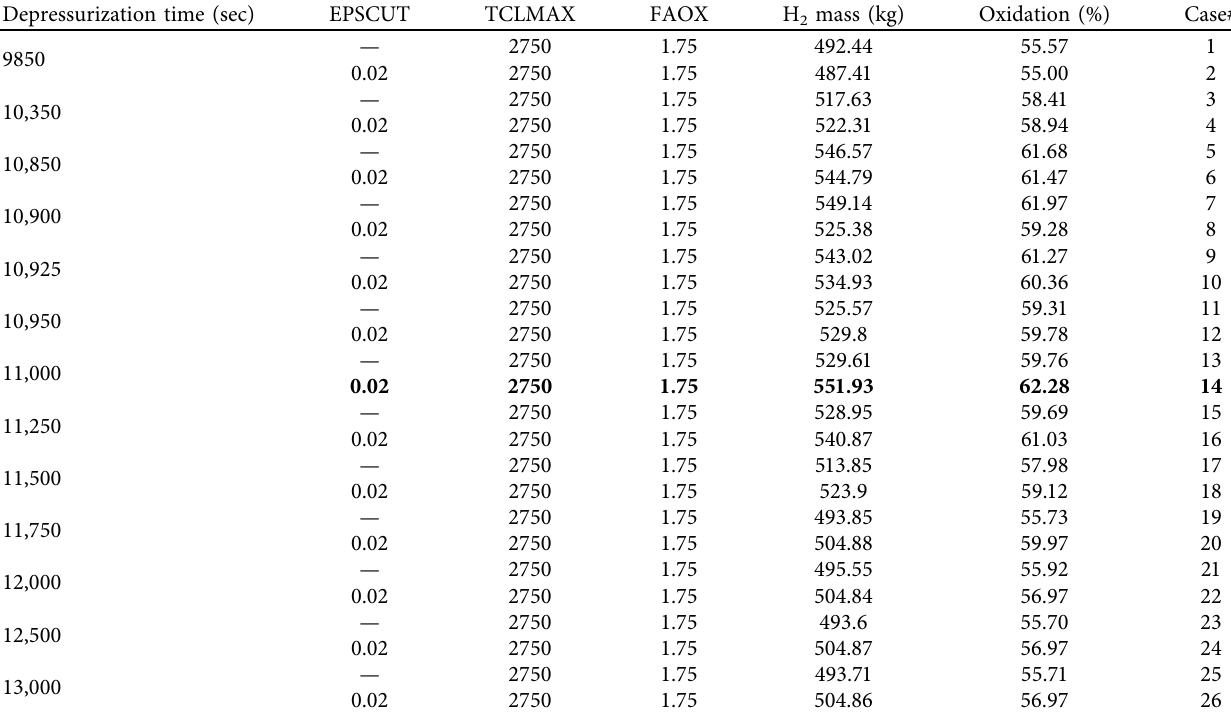
The bold values point to the case with maximum hydrogen production. Table 14: Result of sensitivity study #6 (base case without external